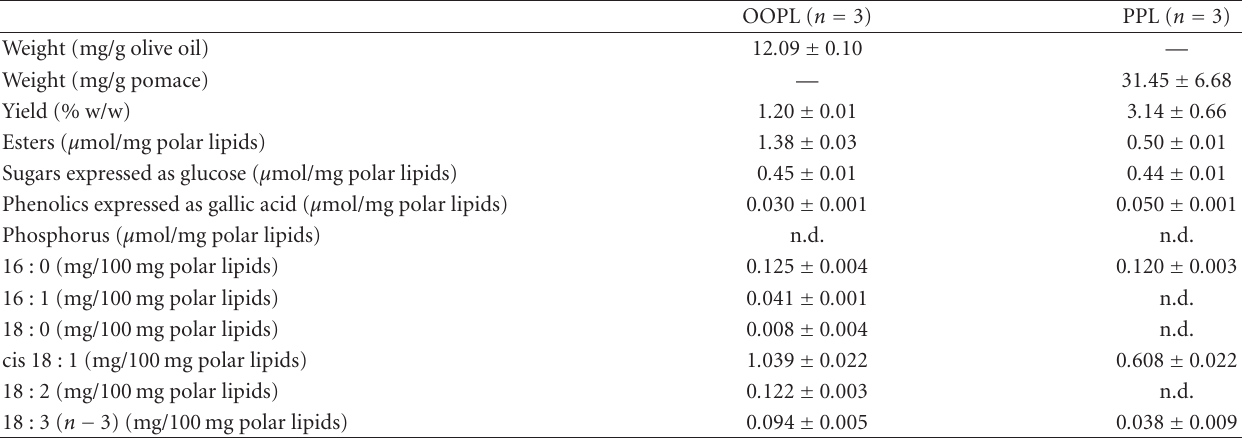
Table 1: Percentage yield, chemical determination, and fatty acid analysis results on OOPL and PPL.